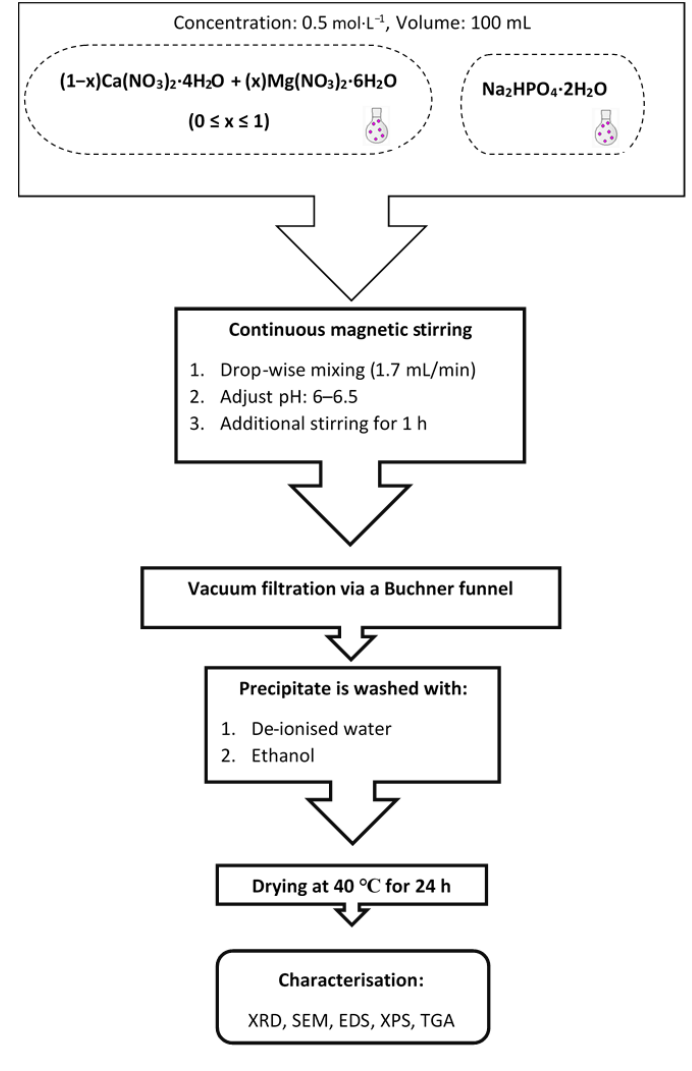
Figure 1. Experimental procedure.